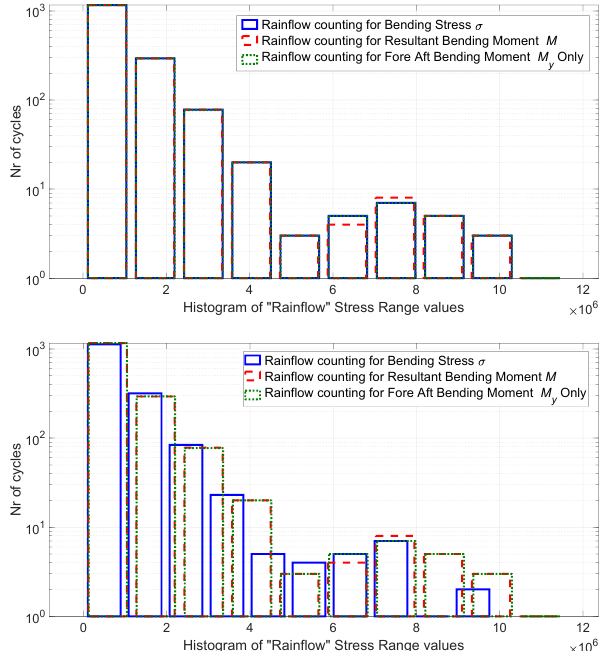
Figure 16. Histograms of 10 min bending stress σ , resultant bending moment M , and fore-aft bending moment M y time series for rated mean wind speed (10 m/s), set θ = 0 ◦ , τ = 0 ◦ ( above ), set θ = 60 ◦ τ = 30 ◦ ( below